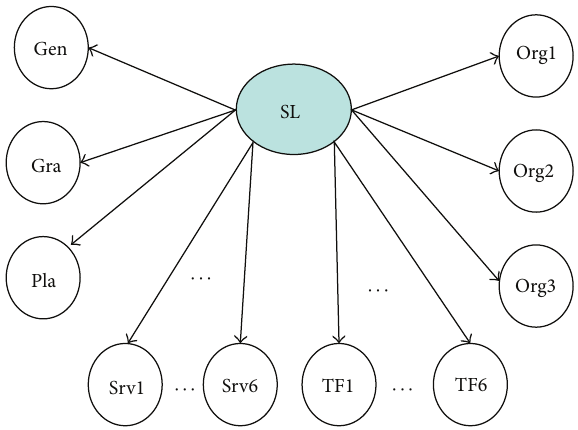
Figure 2: The Bayesian network on service learning benefits.